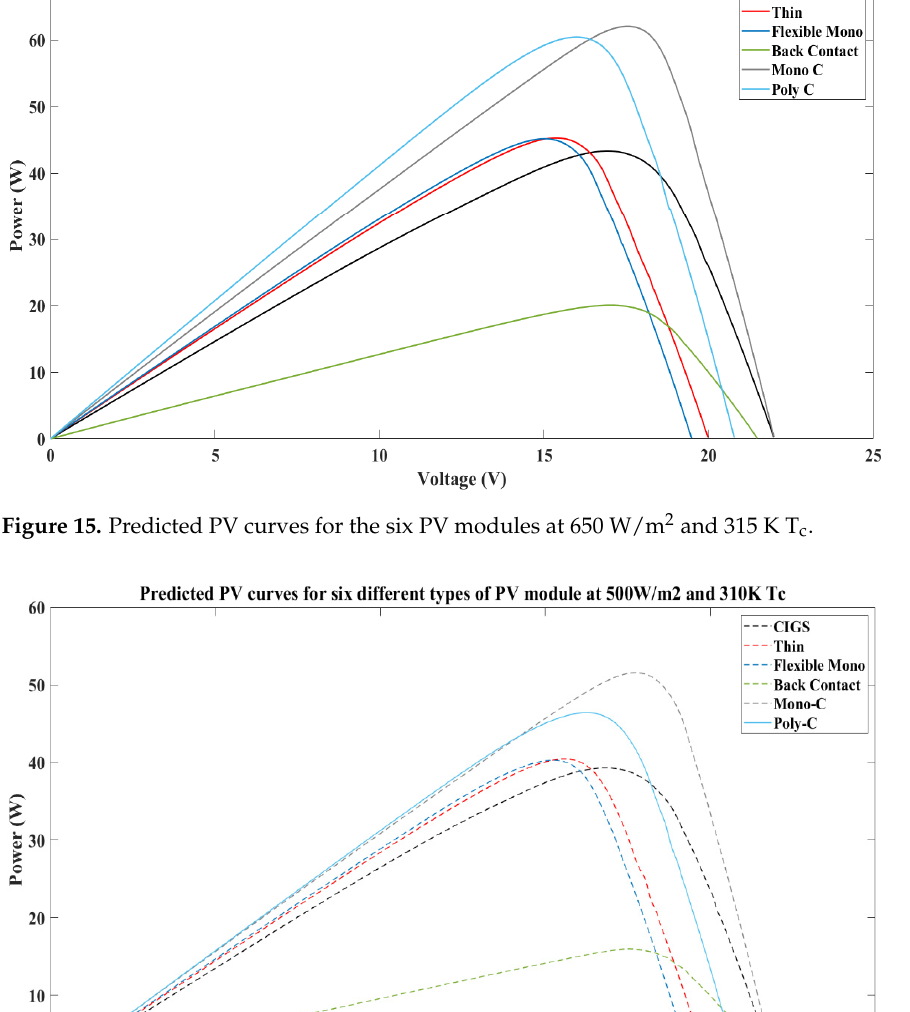
Table 3. FF and efficiency for the six PV modules under the same test conditions.